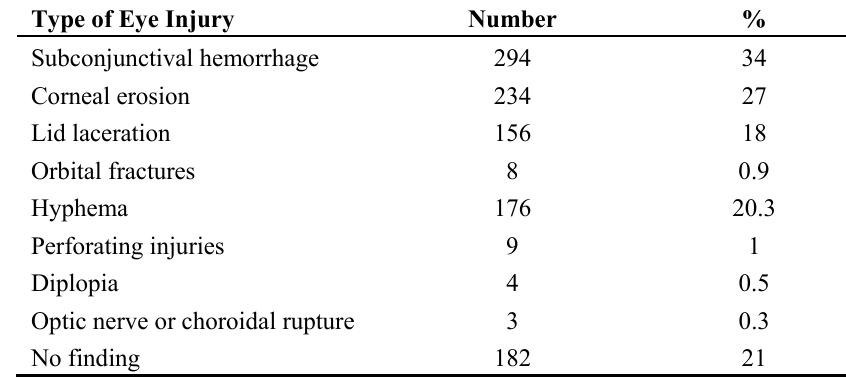
Table 3. Types of eye injuries.